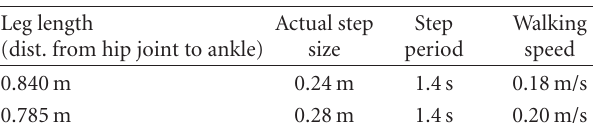
Figure 4: Diagram showing the feedback loop used to control the output torque of the